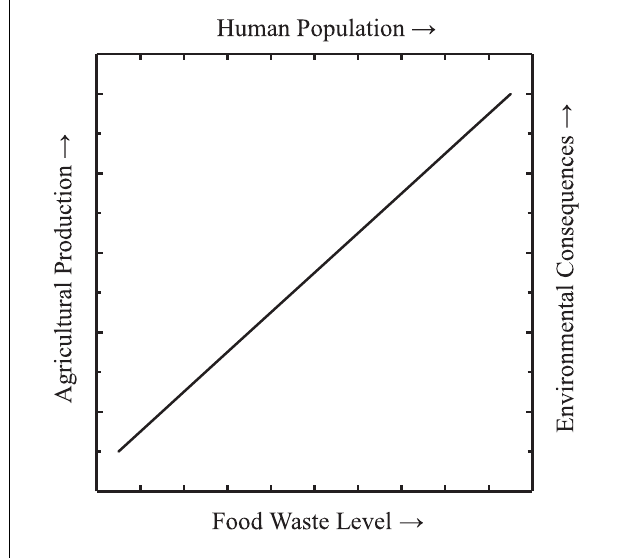
FIGURE 2 | General trend line representing the way in which food waste levels serve as foundational components of related environmental consequences due to ever-growing needs for agricultural productions necessary to support the increasing human population and inevitable urbanization of the United